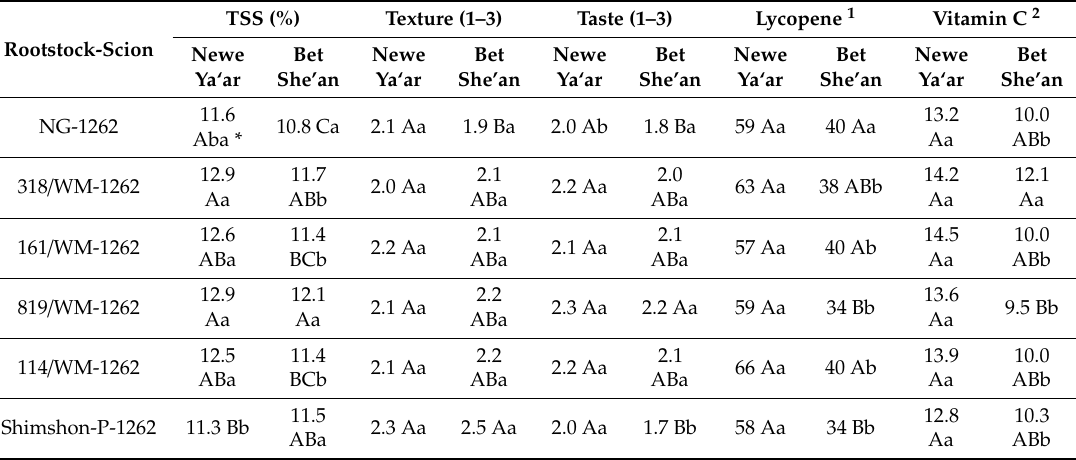
Table 2. The influence of watermelon rootstocks (WM) PI482318 (318), PI549161 (161), PI532819 (819), PI542114 (114), and pumpkin (P) rootstock ‘Shimshon’ on fruit quality after 4 days at 21 ◦ C, from two growing locations, Newe Ya‘ar and Bet She’an. NG: non-grafted control. Means of 8 fruits per treatment.